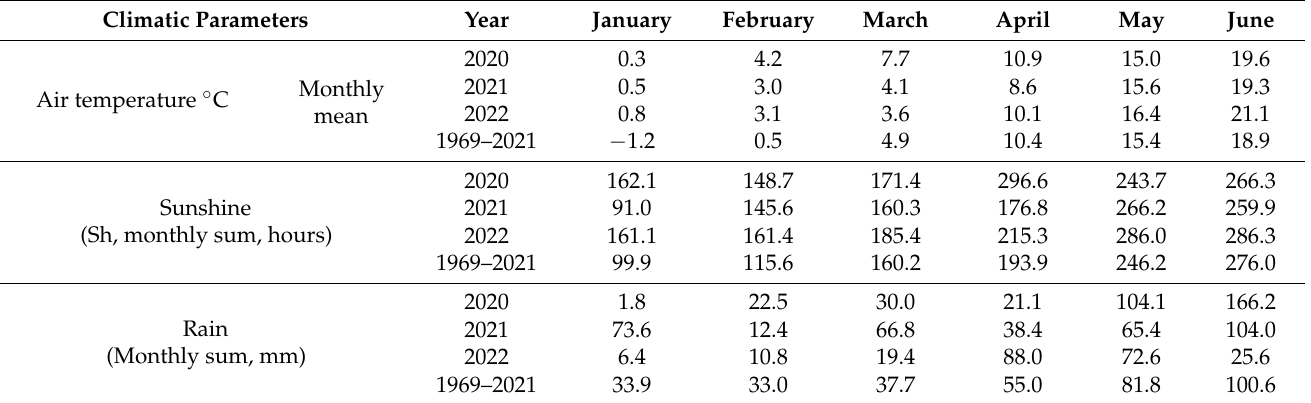
Table 1. Climatic parameters registered in January–June of 2020–2022 and their multiannual values